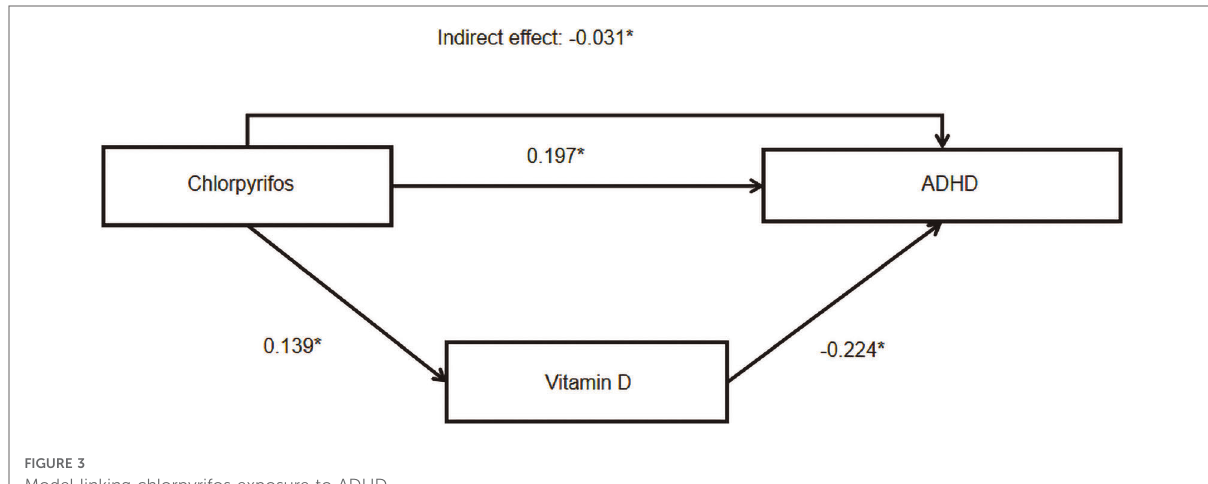
FIGURE 3 Model linking chlorpyrifos exposure to